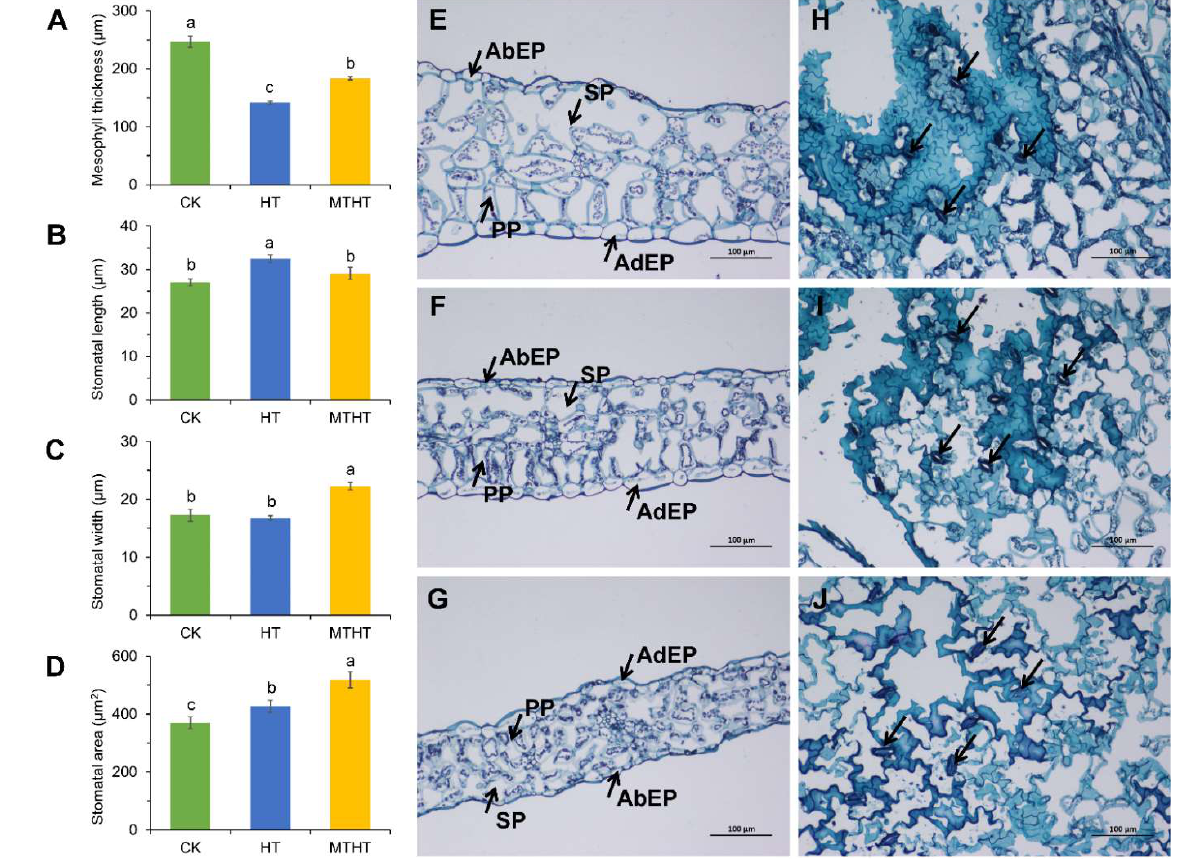
Figure 2. Anatomical characteristics of celery leaves under heat stress. ( A ) Mesophyll thickness, ( B ) stomatal length, ( C ) stomatal width, ( D ) stomatal area, ( E – G ) leaf section, and ( H – J ) leaf plan. SP: spongy tissue; PP: fence organization; AdEp: adaxial epidermal cell layer; AbEp: abaxial epidermal cell layer. Arrows in figure ( H – J ) point to stomata. Each error line represents the mean ± SD, and t -test with significance level of 0.05 ( p < 0.05). Different letters (a–c) indicate significant differences, while the same letter indicates no significant differences.